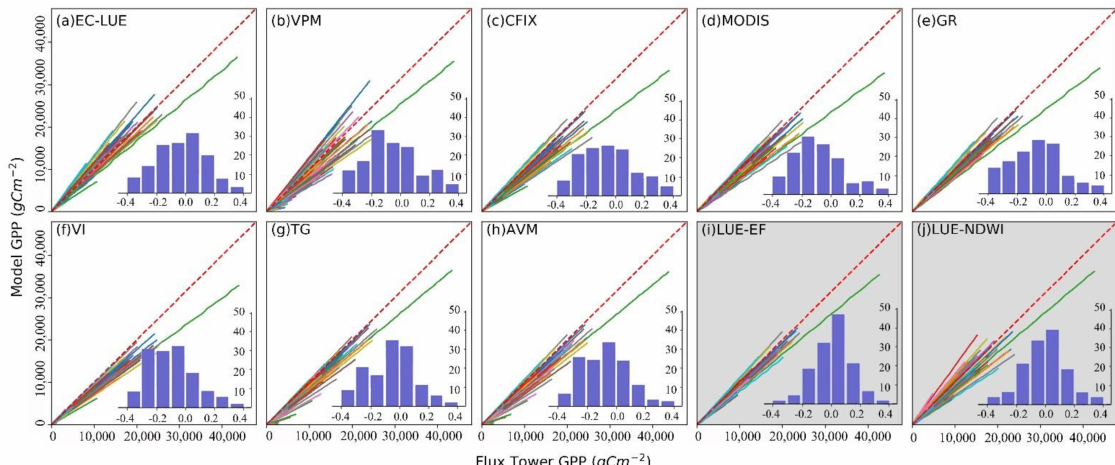
Figure 2. Comparison of cumulative gross primary production (GPP) estimates from the flux towers and the models. The color lines represent the GPP value of cumulative comparison between the EC-tower and model for each site. The red dashed line is the 1:1 reference to the differences of modeled GPP and EC-tower. Inset histogram shows the frequency distribution of the percentage biases (PB) at the flux towers. The two shaded plots (panels i and j) are two new models devel-oped in this study. ( a ) EC-LUE (eddy covariance-light use efficiency model), ( b ) VPM (vegetation photosynthesis model), ( c ) CFIX (carbon fixation model), ( d ) MODIS (moderate resolution imaging spectroradiometer model), ( e ) GR (green-ness-radiation model), ( f ) VI (vegetation-indices model), ( g ) TG (temperature-greenness model), ( h ) AVM (alpine vegetation model), ( i ) LUE-EF (light use efficiency-evaporative fraction model), ( j ) LUE-NDWI (light use efficiency-normalized difference water index